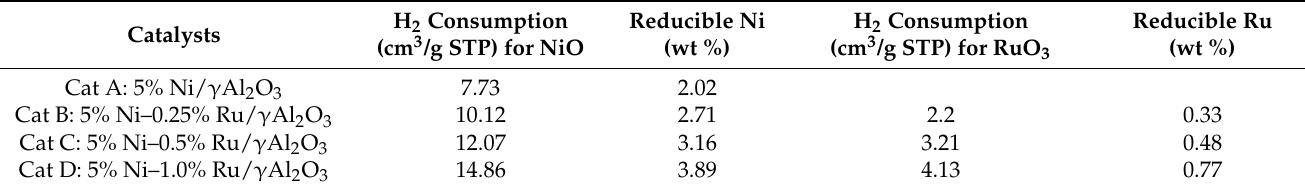
Table 3. NiO and RuO 3 hydrogen consumption and reducible Ni and Ru